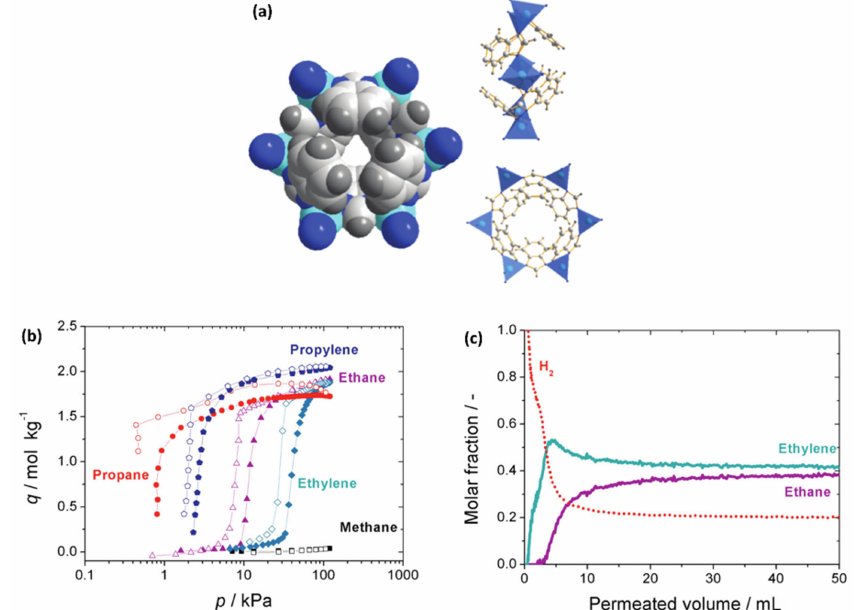
Figure 14. ( a ) Main cavity of ZIF-7 ( Left ). Lateral ( Top Right ) and front ( Bottom Right ) views of the six-membered-ring pore opening. Zn clusters are represented as polyhedra. ( b ) Adsorption (closed symbols)-desorption (open symbols) isotherms of several hydrocarbons on ZIF-7 powder at 25 ◦ C. ( c ) Breakthrough curve obtained for an equimolar mixture of C 2 H 4 and C 2 H 6 on a column packed with ZIF-7 pellets at 25 ◦ C and 1 bar. H 2 , contributing the 20% of the mixture flow